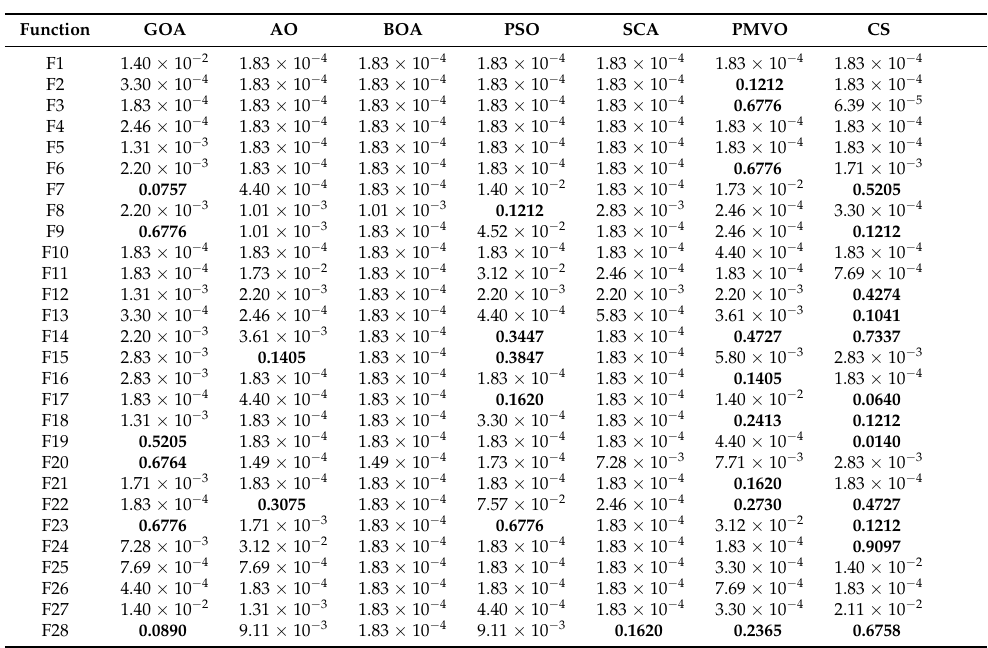
Table 2. p -Values of the Wilcoxon rank-sum test for CEC2013